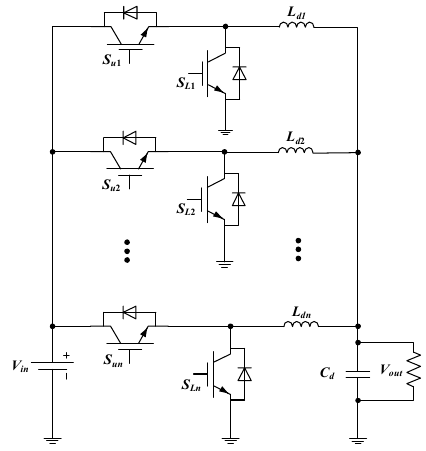
Figure 8. Multiphase interleaved soft-switching synchronous buck converter.